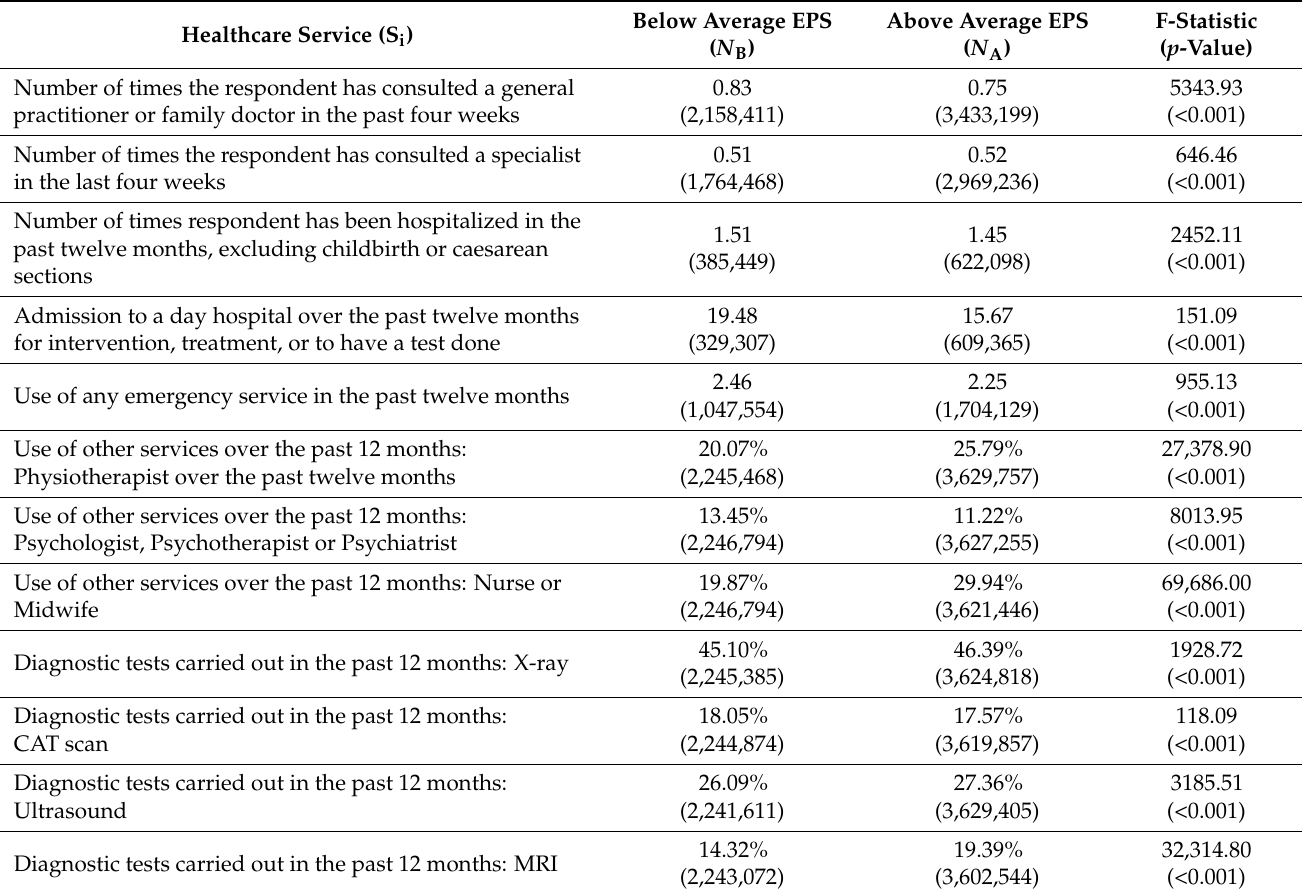
Table 6. Average use of healthcare services by women with limitations (EPS